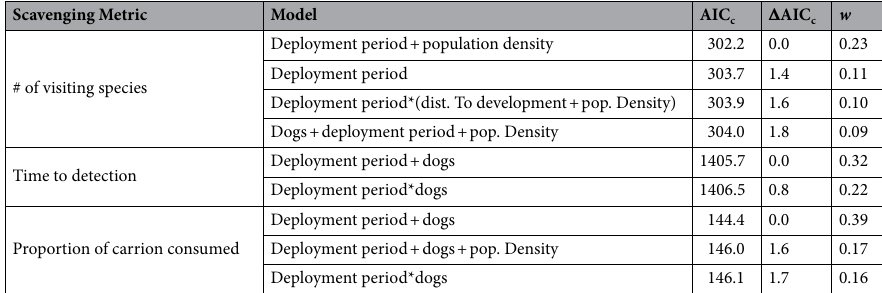
Table 2. Top-ranked models describing the factors influencing the scavenger community and scavenging efficiency on ocean-exposed sandy beaches in New Jersey, USA. AIC c is the Akaike’s information criterion corrected for small sample size; (cid:31) AIC c is the difference between the AIC c value for a given model and the top model; w is the Akaike weight.